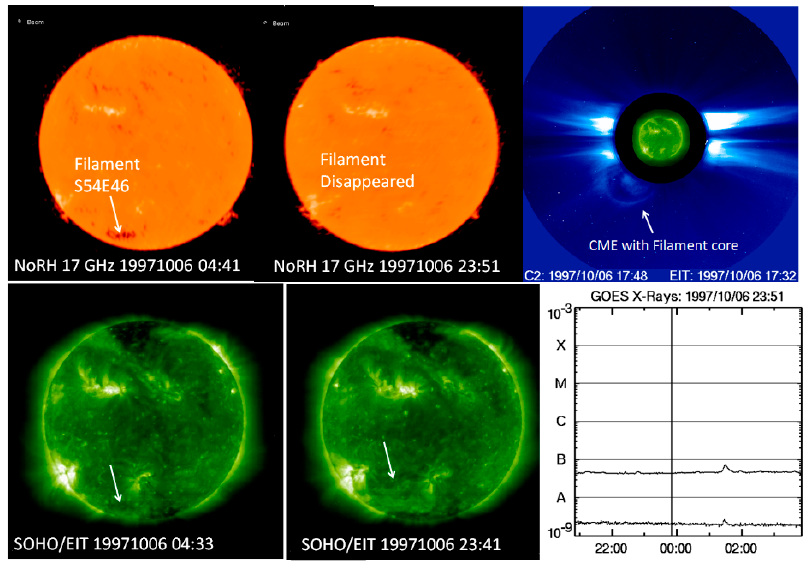
Figure 6. ( top row ) CME–flare relationship, illustrated using the 6 October 1997 filament eruption event. The Nobeyama Radioheliograph (NoRH) image at 04:41 UT shows the filament located in the southeast quadrant (S54E46), while the image at 23:51 UT shows the filament has disappeared and ended up as the bright core of the SOHO/LASCO CME. ( bottom row ) The filament is also observed in the 04:33 UT EUV image obtained by SOHO/EIT at 195 Å. After the filament disappeared, a post-eruption arcade formed in the vicinity of the filament’s pre-eruption location. The PEA is so faint that it cannot be discerned in the GOES light curve.